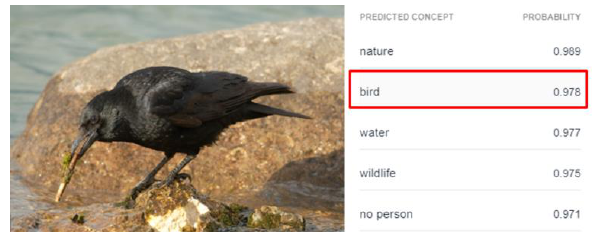
Figure 3: An example of Clarifai predicted tags and their probabilities for an image